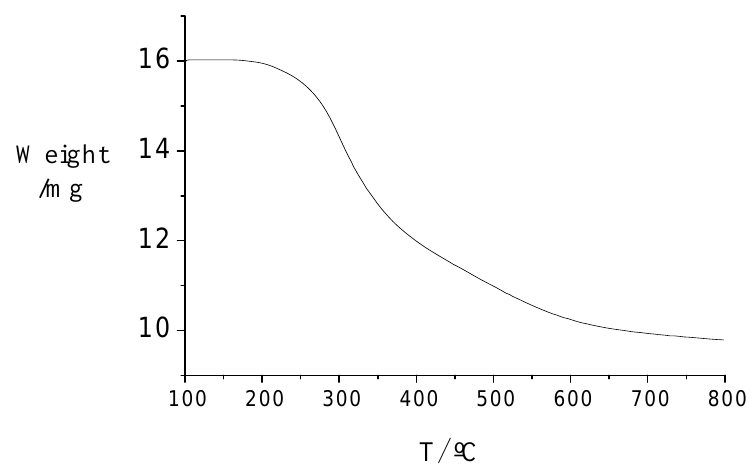
Figure 1. The TG curve of the novel catalyst.